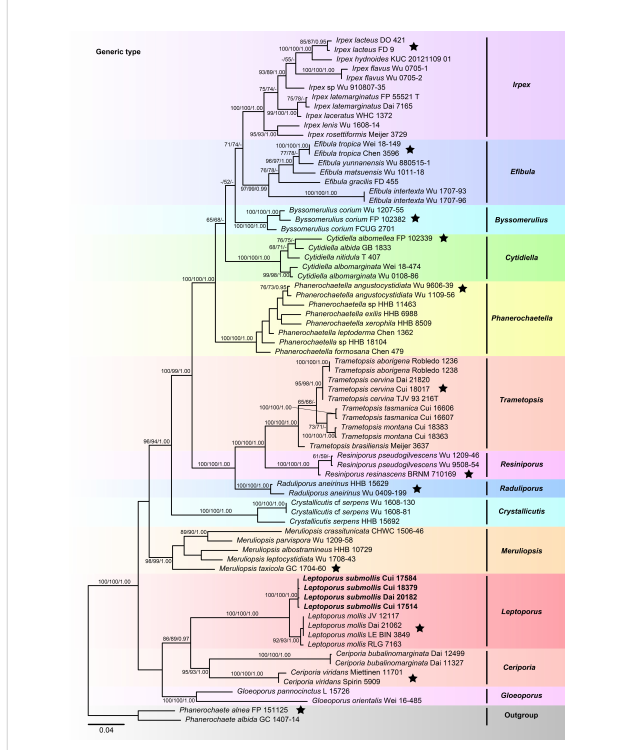
FIGURE 1 Maximum likelihood tree illustrating the phylogeny of Irpicaceae based on the combined sequence dataset of ITS+nLSU. Branches are labeled with maximum likelihood bootstrap higher than 50%, parsimony bootstrap proportions higher than 50%, and Bayesian posterior probabilities more than 0.90, respectively. Bold names = New